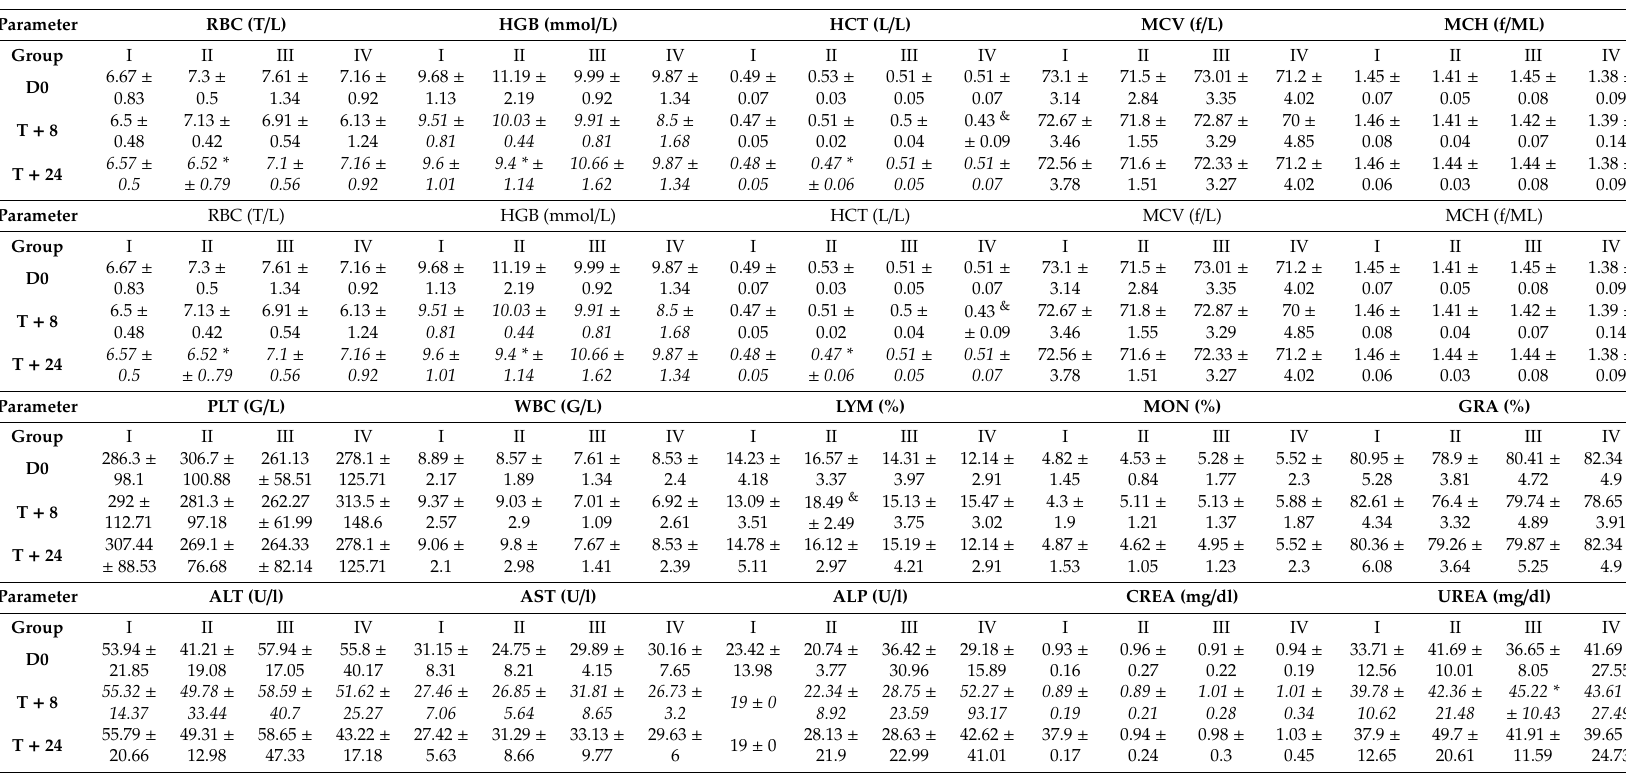
Table 3. Comparison of selected blood morphology and biochemistry parameters between control (I and II) and experimental (III and IV) groups in relation to day 0 (D0), week 8 (W + 8) and week 24 (W + 24) (mean, SD). Parameter